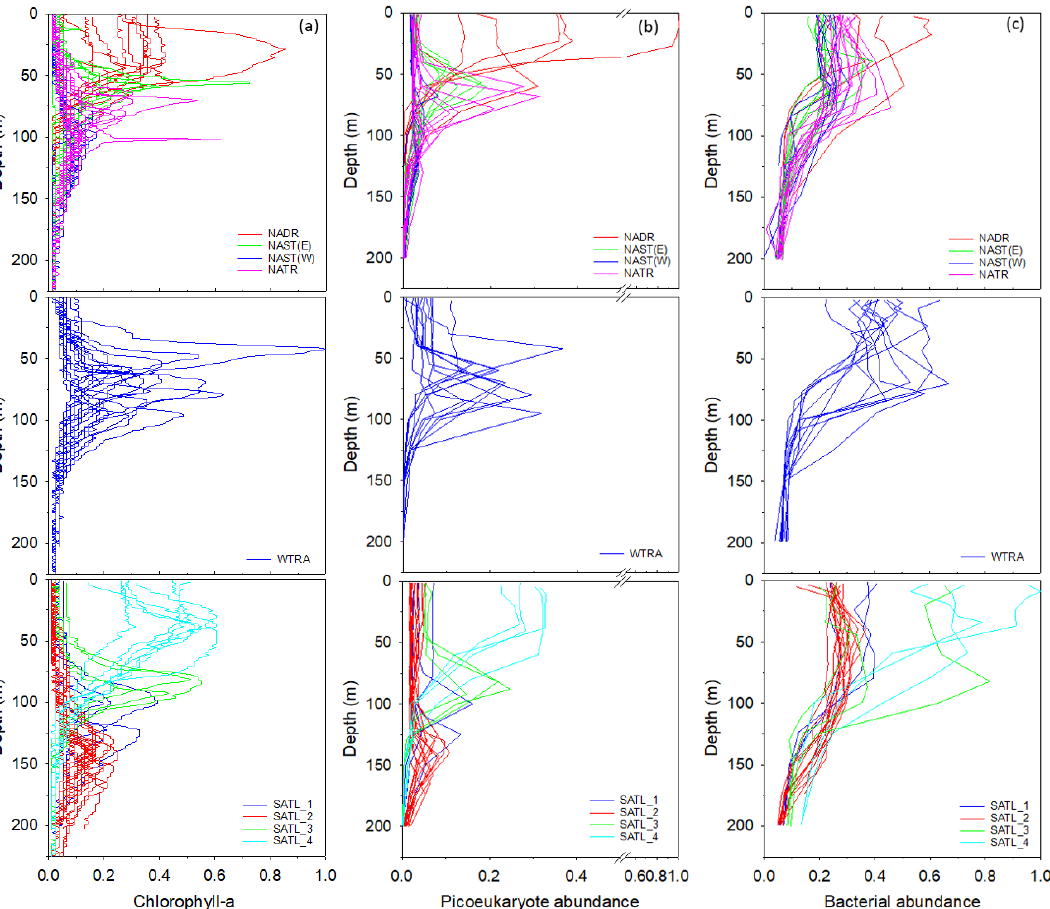
Figure 5. Profiles of chlorophyll- a concentration (a) , the abundance of picoeukaryotes (b) , and bacteria (c) within Longhurst provinces (defined in Fig. 1). Data are presented as a ratio of the maximum value measured for each parameter throughout the transect. Profiles frequently describe comparable distributions within a defined province. However, data are sub-divided within the SATL province to illustrate apparent distinctions in vertical